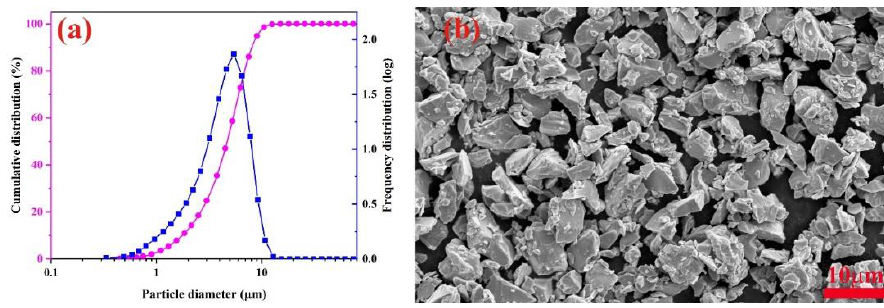
Figure 1. ( a ) Particle size distribution and ( b ) microscopic morphology of Sm 2 Fe 17 N 3 fine powder. Table 1. Oxygen content (ppm) summary of Ce 72 Cu 28-x Al x alloy strip and powders after ball milling.